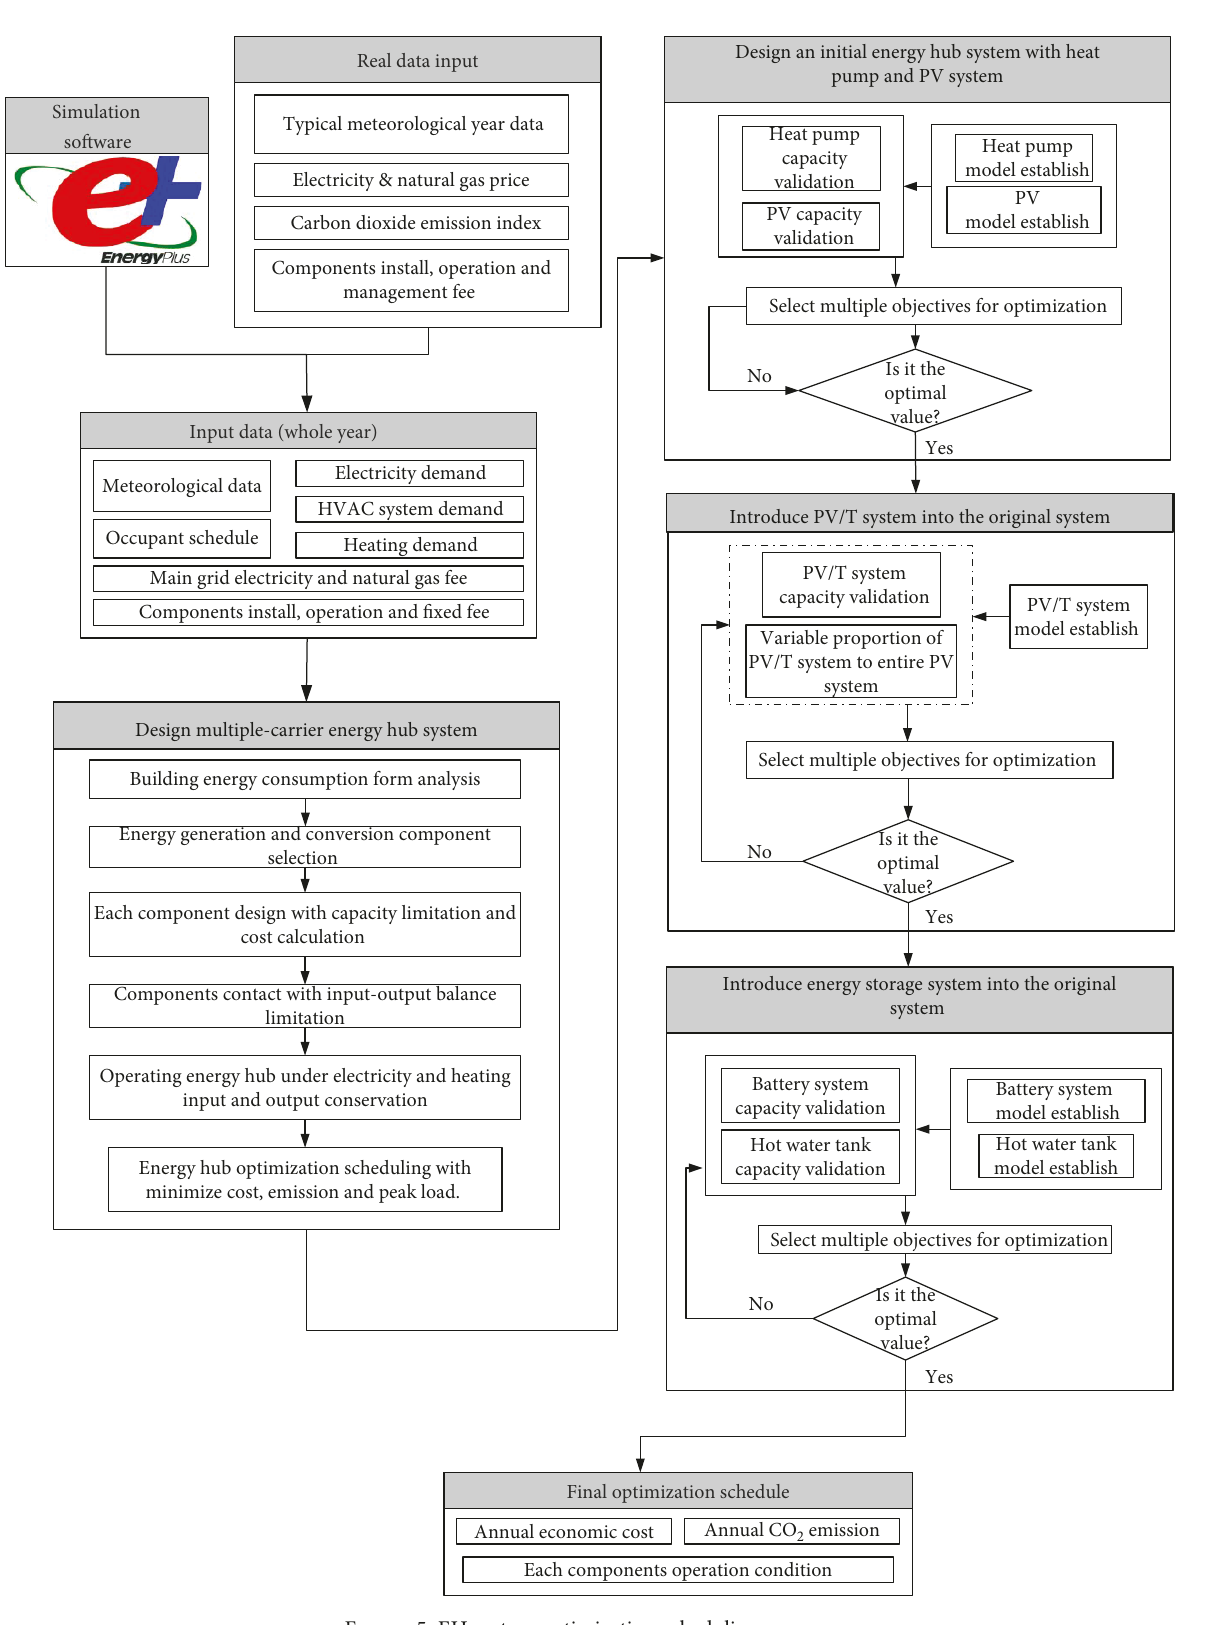
Figure 5: EH system optimization scheduling